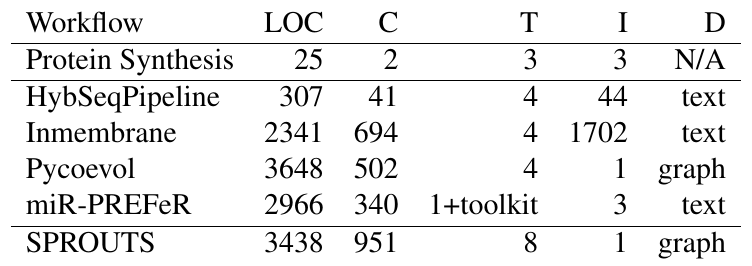
Table 1: Characteristics of test workflows. LOC is the total of lines of code, C denotes the number of lines of comments. T is the number of tools identified in the code, I the size of input and D the availability of a workflow